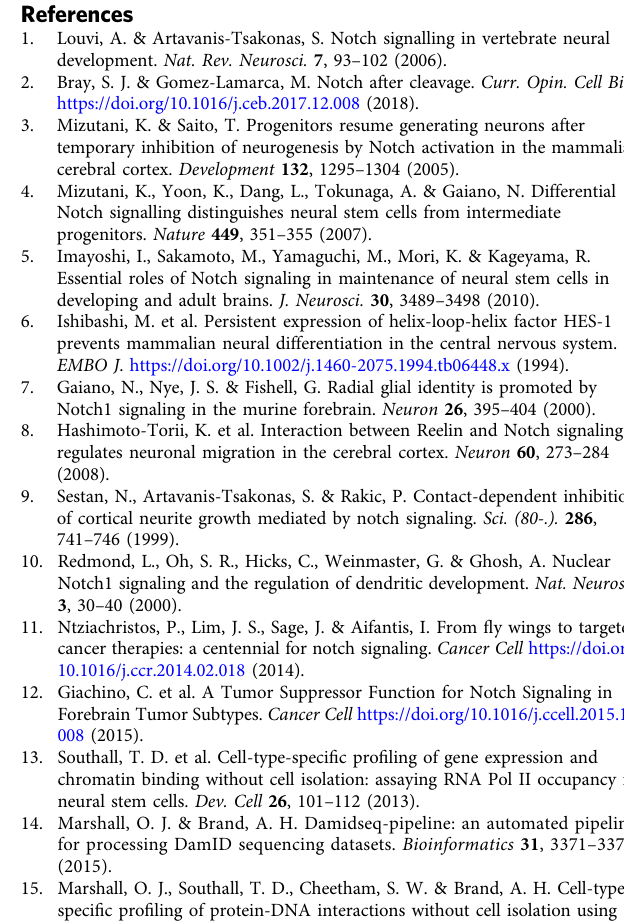
Table 5 (https://academic.oup.com/stmcls/article/30/4/741/6415703) and differential gene expression from their Supplementary Table 1 (https://academic.oup.com/stmcls/ article/30/4/741/6415703). Source data are provided with this